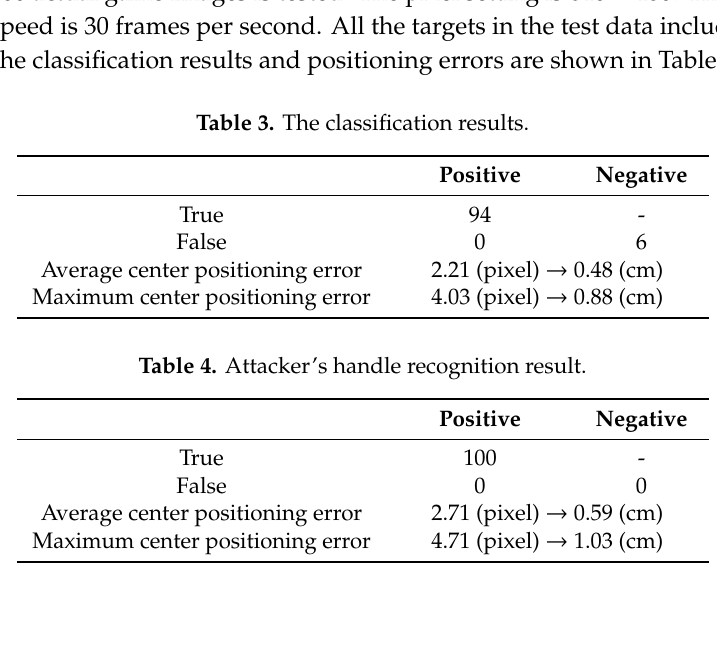
Table 2. Hardware equipment.